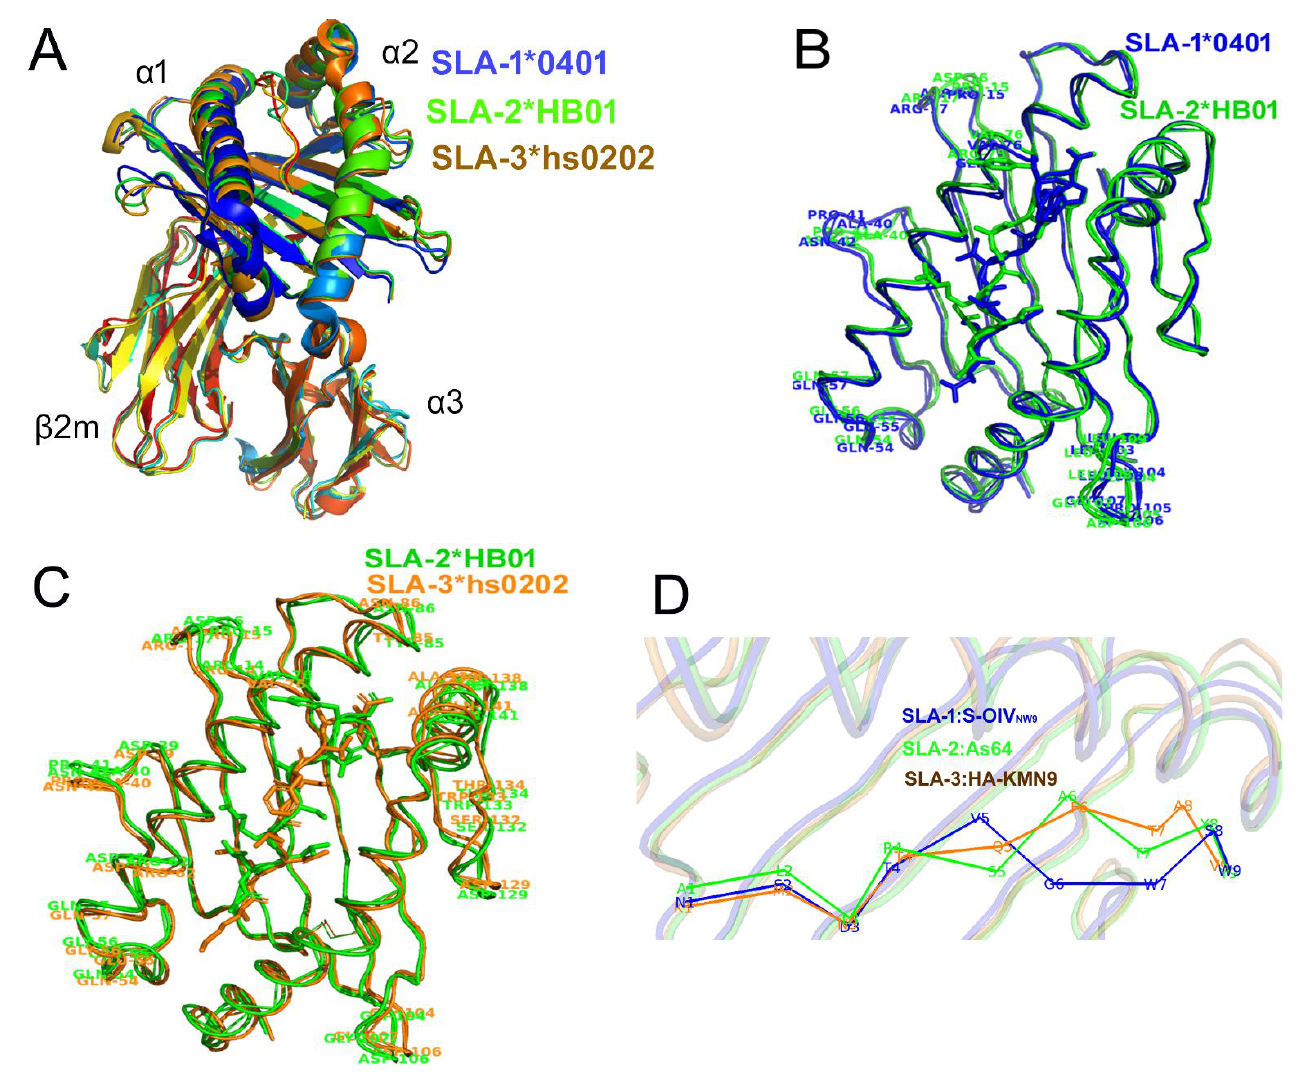
Figure 3. A comparison of the crystal structures of SLA-2*HB01, SLA-1*0401, and SLA-3*hs0202. ( A ) The superposition of the overall structures of SLA-2*HB01, SLA-1*0401, and SLA-3*hs0202, which are all displayed as a cartoon model, with a heavy chain comprising the α 1, α 2, and α 3 domains and a light chain s β 2 m. ( B ) Aligning the peptide-binding grooves of SLA-2*HB01 and SLA-1*0401. The peptide S-OIV NW9 bound to SLA-1*0401 and the peptide As64 bound to SLA-2*HB01 are shown by blue and green sticks, respectively. The peptide-binding grooves from SLA-1*0401 and SLA-2*HB01 are respectively shown by blue and green loops. The labeled amino acids are shown in the same color as their chains. ( C ) Aligning the peptide-binding grooves of SLA-2*HB01 and SLA-3*hs0202. The peptide As64 bound to SLA-2*HB01 and the peptide HA kmN9 bound to SLA-3*hs0202 are shown by green and orange sticks, respectively. The peptide-binding groove from SLA-2*HB01 and the peptide-binding groove from SLA-3*hs0202 are respectively shown by green and orange loops. The labeled amino acids are shown in the same color as their chains. ( D ) Comparing the peptide refolding of SLA-1*0401, SLA-2*HB01, and SLA-3*hs0202. The peptides are all shown in cartoon style and labeled in different colors. The blue color indicates S-OIV NW9 from SLA-1*0401; the green indicates As64 from SLA-2*HB01; and the orange indicates HA kmN9 from SLA-3*hs0202. The amino acids (one letter) are labeled in the same color as in their cartoon models.